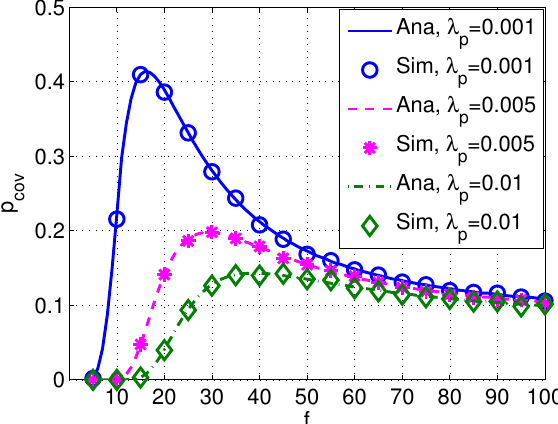
Figure 9. Coverage p cov versus frequency f with different λ p . System parameters are set as R d = 12 km, P p = 110 dB, P s = 100 dB, s = 1, k = 1, w = 10 m/s, δ s = 20 dB, and δ d = 20 dB.